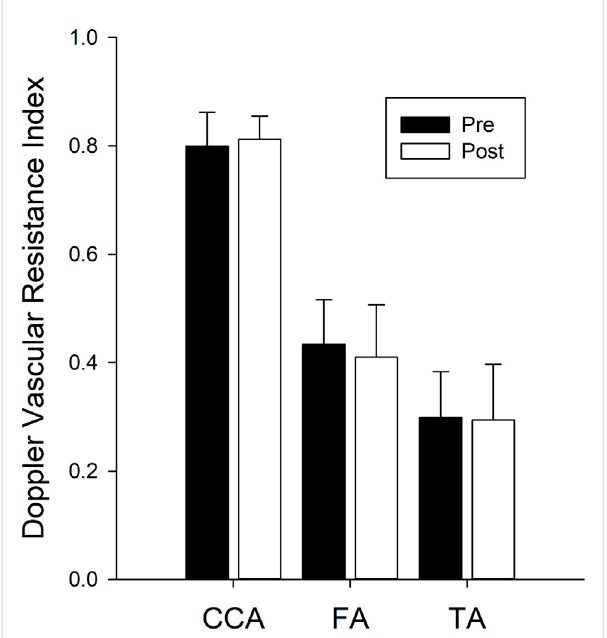
FIGURE 4 Barsrepresentthemean±SDfortheDopplervascularresistance indices (n= 14 for all threevessels)calculated for thecommon carotid artery (CCA), femoral artery (FA), and tibial artery (TA). There were no differences between values calculated pre isolation (black bars) and post isolation (white